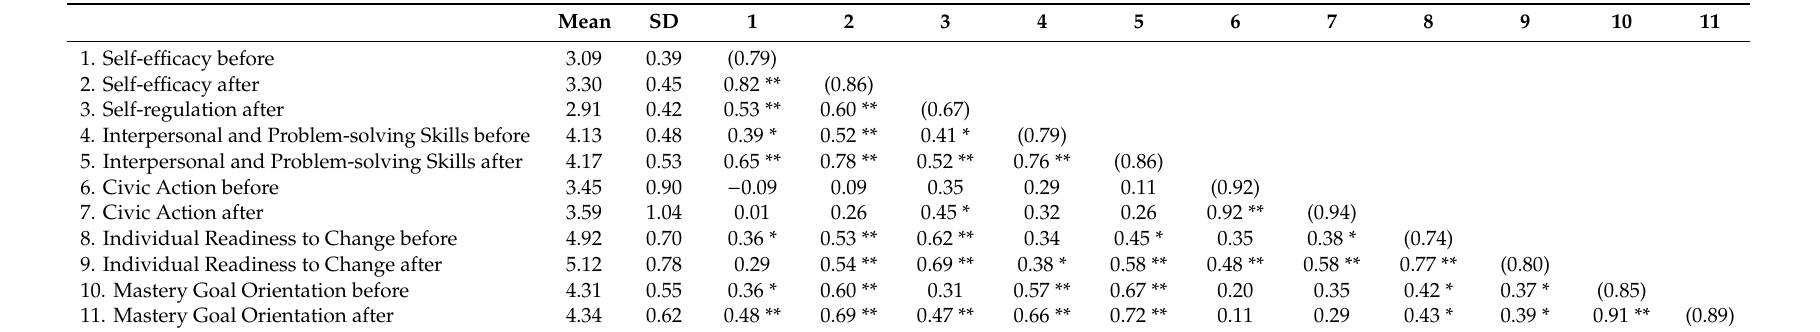
Table 1. Aggregated metacognitive skill training variable correlations.